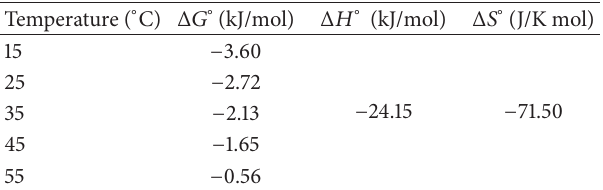
Table 8: Thermodynamic parameters for the adsorption of AB1 on CTS/feldspar (pH, 3; Co, 125 mgL − 1